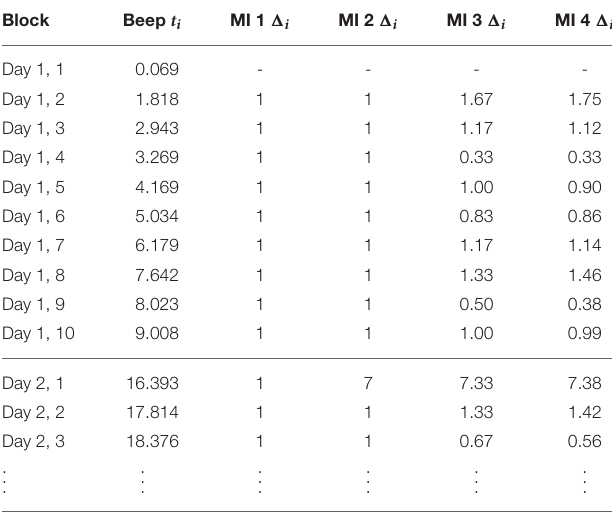
TABLE 1 | Illustration of the difference between the true time intervals, which are used in the CT model (MI4 1 i ) and are given in the right-most column, and the assumed time intervals in the other model implementations (MI 1 to MI 3, in worst to best